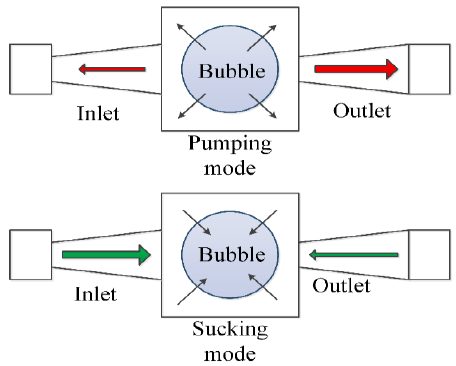
Figure 1. Working principle of the bubble actuated valveless micro-pump.